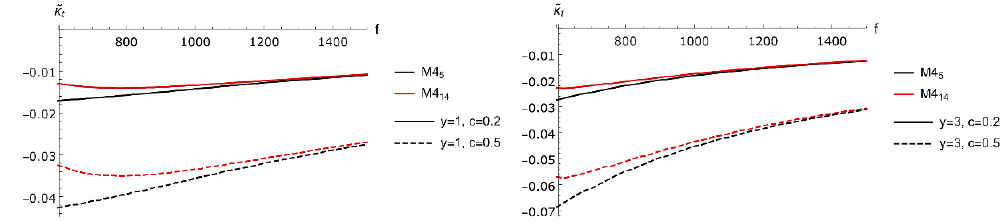
Figure 6 . The CP-odd top-quark Yukawa coupling varies in the fourplet models as a function of f , for M (cid:9) = 1200 GeV, M (cid:9) = 1300 GeV, and for di(cid:11)erent values of the parameters y and c . 1 2